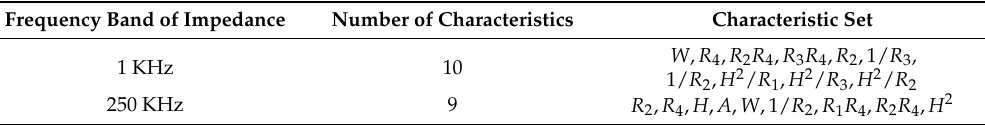
Table 1. The filtered and clustered characteristic parameters.